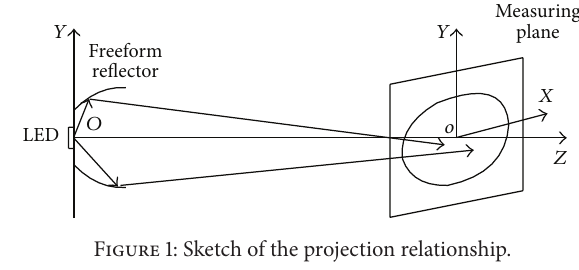
Figure 1: Sketch of the projection relationship.